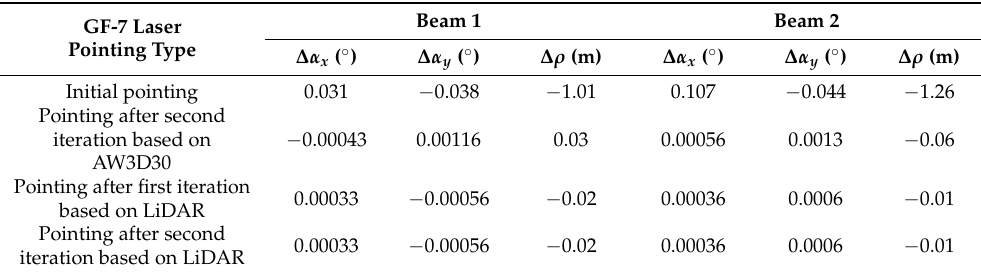
Table 6. Laser pointing angle and ranging accuracy of GF-7 laser calibrations based on AW3D30 and LiDAR.